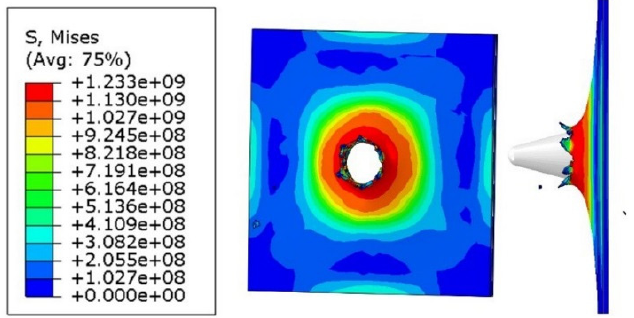
Figure 22. HMH stress visualization for two layers of titanium alloy.